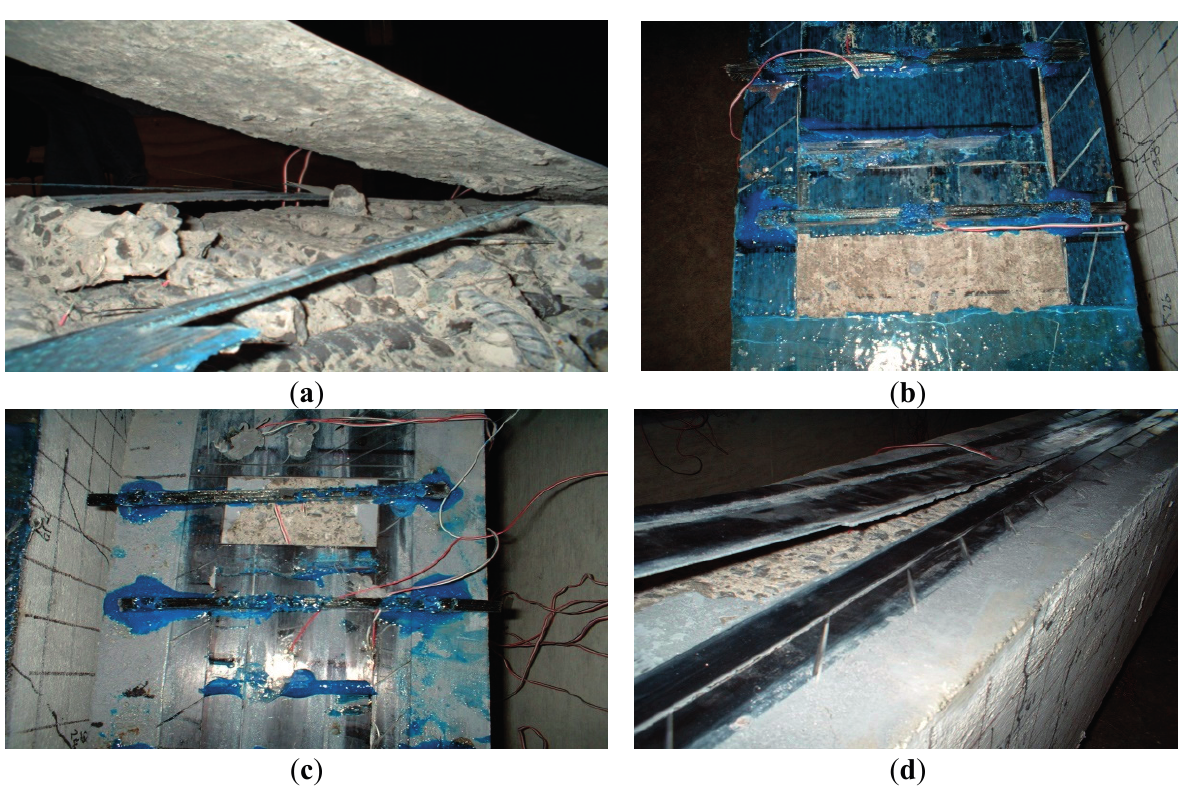
Figure 7. Typical failure for beams with and without anchors. ( a ) Debonding in Beam SN166; ( b ) Sheet end slippage in Beam SA166; ( c ) Slippage happened in Beam LA100; ( d ) Debonding in Beam